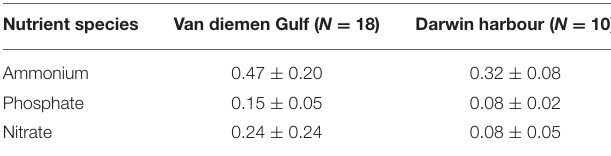
particle assemblage characterizing the two regions, also reflected in b e bp (555). In contrast, the dominance of organic material during the wet season months is consistent with an enhanced